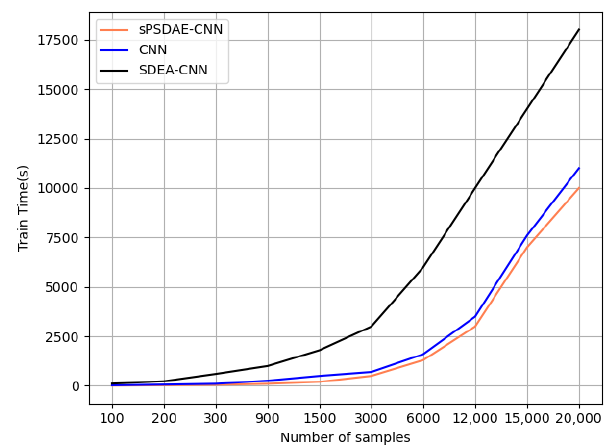
Figure 17. Comparison of training time required by different neural network models under different data